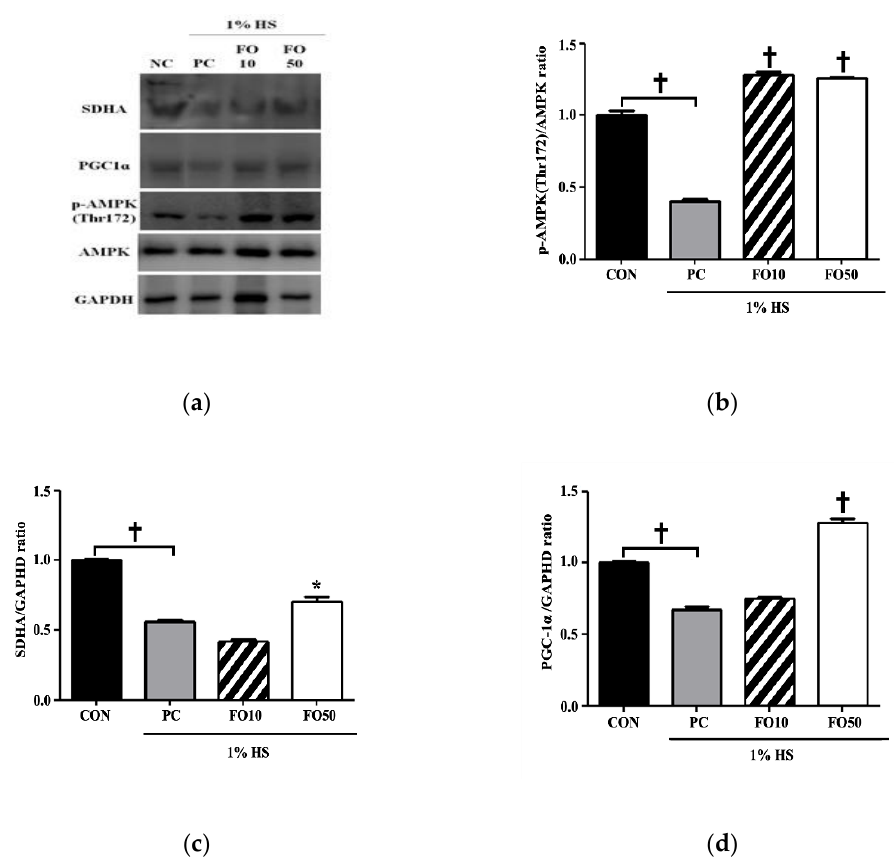
Figure 7. ( a ) Representative image of Western blot analysis. Changes in ( b ) phospho-adenosine monophosphate-activated protein kinase (p-AMPK), ( c ) succinate dehydrogenase (SDHA) and ( d ) peroxisome proliferator-activated receptor gamma coactivator-1 α (PGC-1α levels were determined in C2C12 muscle cells following administration of 10 and 50 μg/mL of FO. Each bar represents the mean ± SD. A one-way ANOVA test was carried out to determine significant differences (* p < 0.05 vs. positive control, † p < 0.001 vs. positive control).